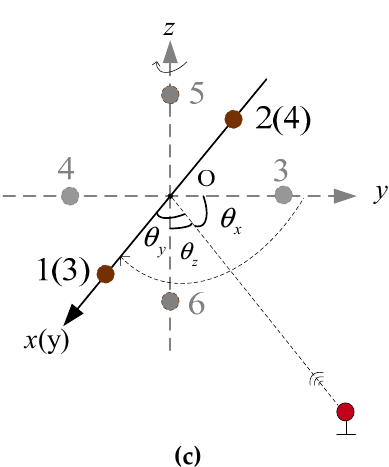
Figure 6. The rotating schematic diagram of the USBL array based on the rotating array and reusing elements. ( a ) The schematic diagram of the U -frame rotating 90° clockwise around the y-axis; ( b ) the schematic diagram of the U -frame rotating 90° clockwise around the x -axis; and ( c ) the schematic diagram of the U -frame rotating 90° clockwise around the z-axis.